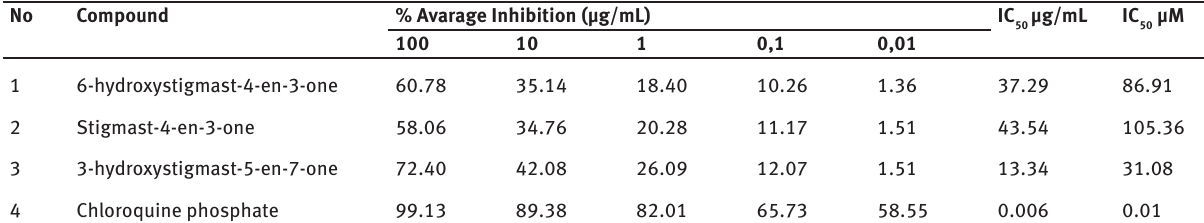
Table 1: Avarage Inhibition of isolated compounds (1-3) and Chloroquine phosphate against P. falcifarum 3D7. No Compound % Avarage Inhibition